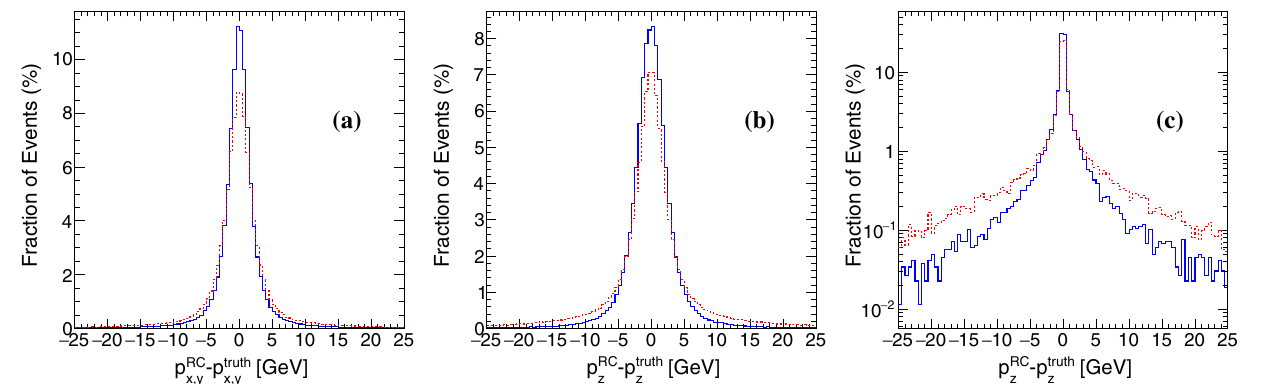
Fig. 1 The resolutions of the Higgs recoil momentum in x and y ( a ) and in z ( b ) in the Z → jj channels, and in z in the Z → (cid:3)(cid:3) channels ( c ). The red dashed (blue solid) histogram corresponds to the calcula- Fig. 2 Plots demonstrating the tau flight vector, the track trajectory and the point of closest approach for three cases: a the collision point O is inside the track curvature, b O is outside the track curvature with two intersection points, c O is outside the track curvature with no